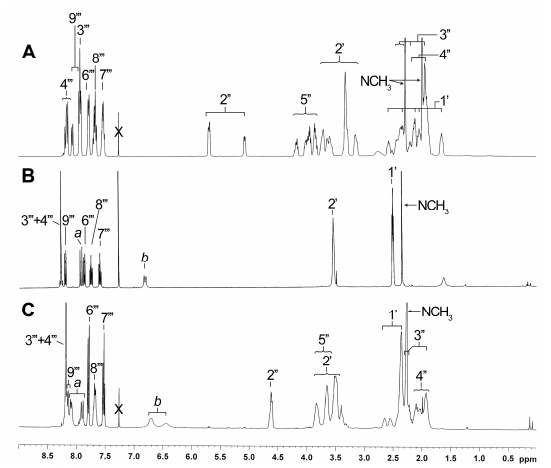
Figure 3. Comparison of 1 H NMR spectra in CDCl 3 of known side chain 6 ( A ) and unknown side chains 7a ( B ) and 8a ( C ).